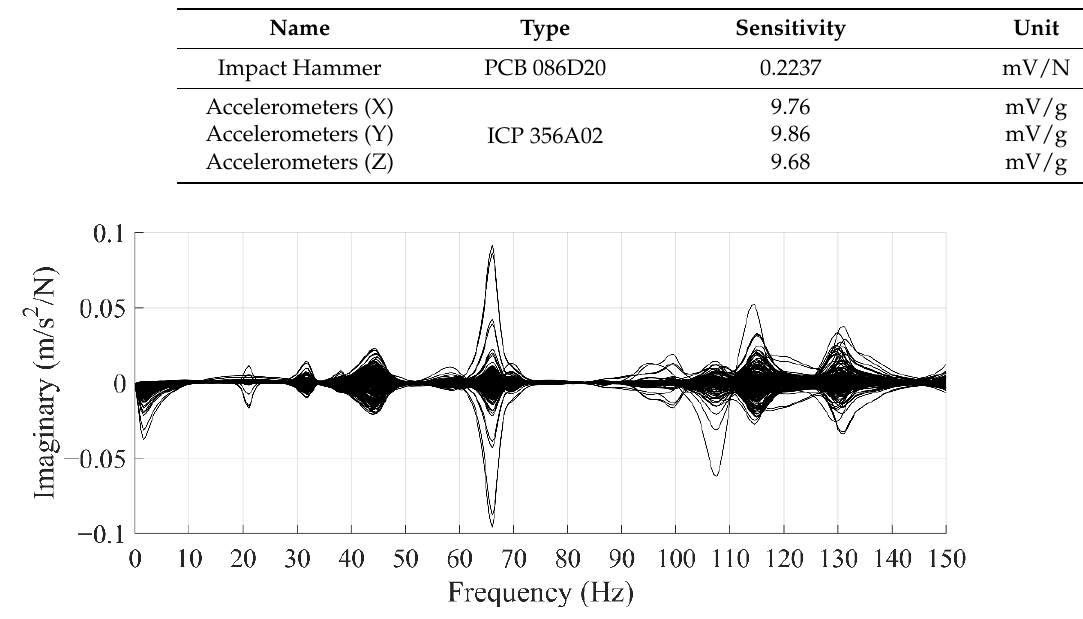
Figure 10. Frequency response function.